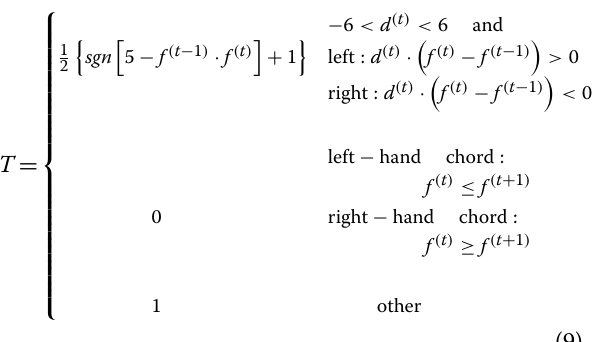
Decision function T is based on the data in Table 1, as shown in (9). This also imposes restrictions on the finger- ing of chords, due to the prohibition on finger crossing and repetition. The right-hand maximum span [4] of 5 limits the scope of T in the monophonic type. Due to the mirror-symmetry in the physiological structure of the two hands, we can assume that the maximum span also applies to the left hand.